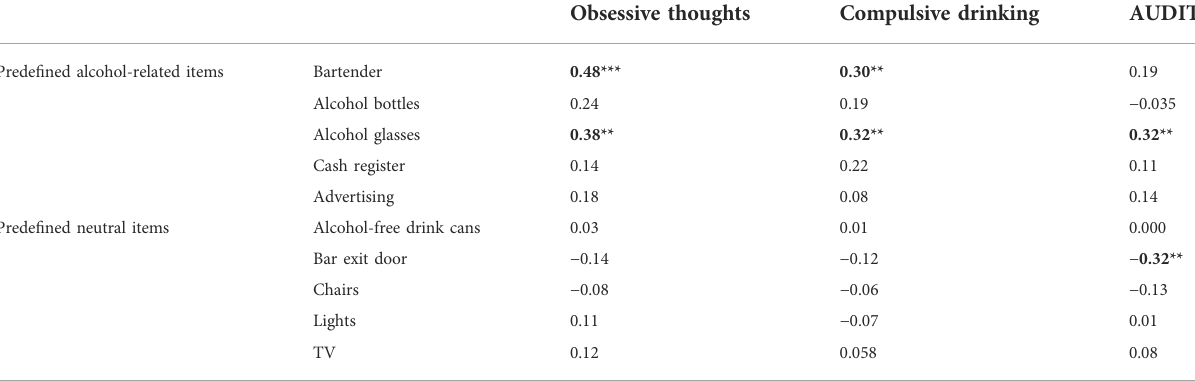
TABLE 4 Bilateral Kendall ’ s correlations between OCDS, AUDIT and dwell